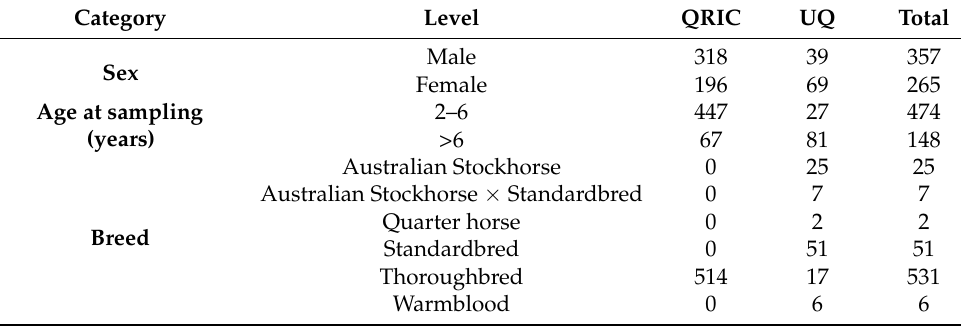
Table 2. Description of the sample population.